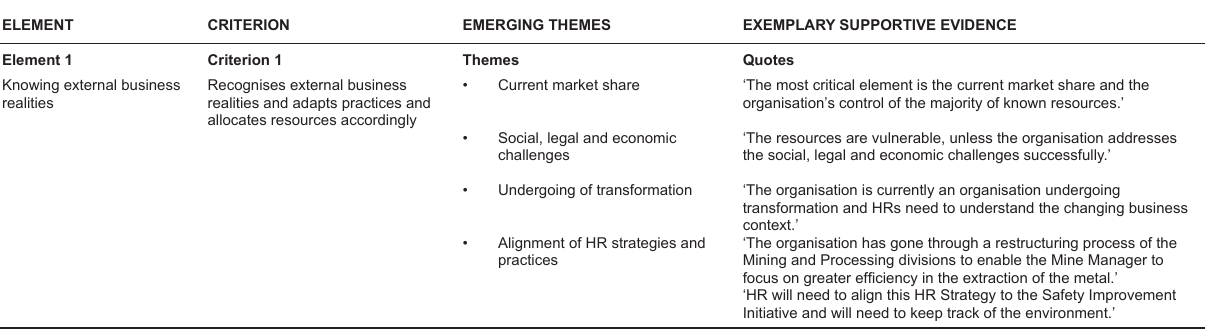
TABLE 2 Emerging themes pertaining to Element 1: Knowing external business realities